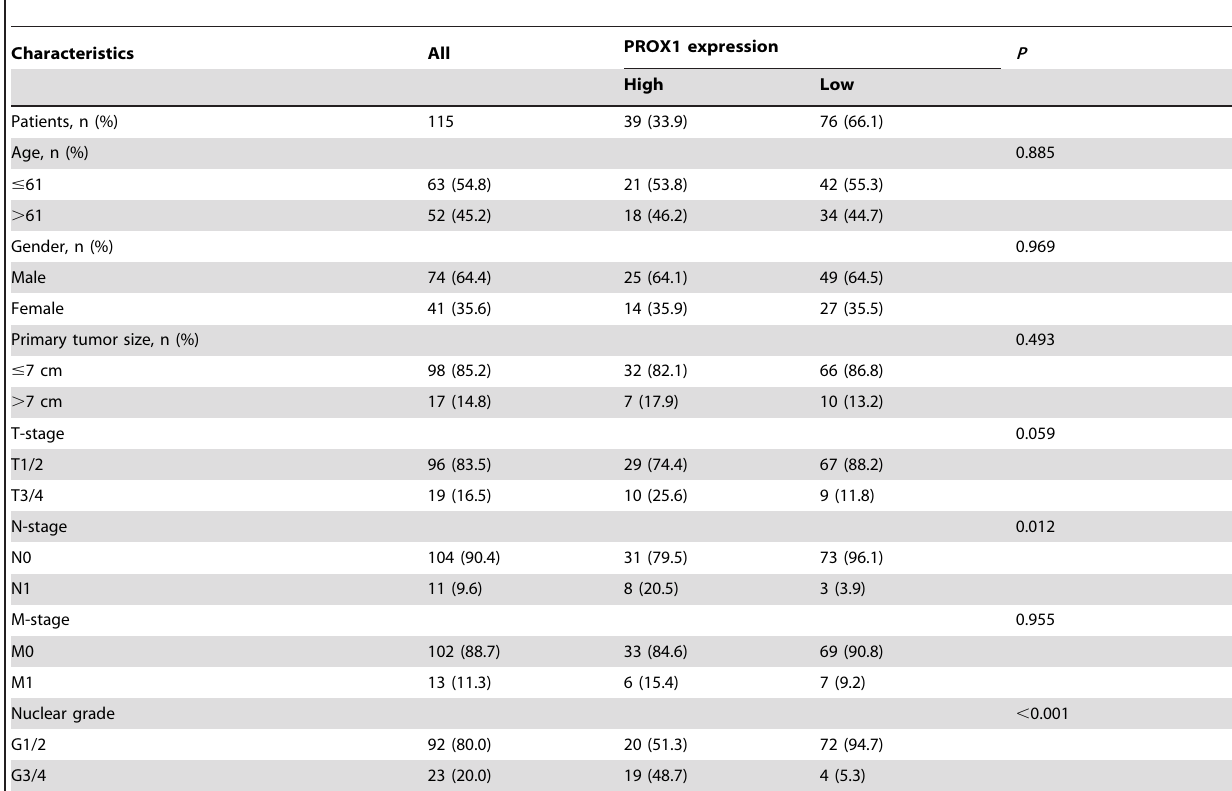
Table 1. Correlation between clinicopathological parameters and PROX1 expression.